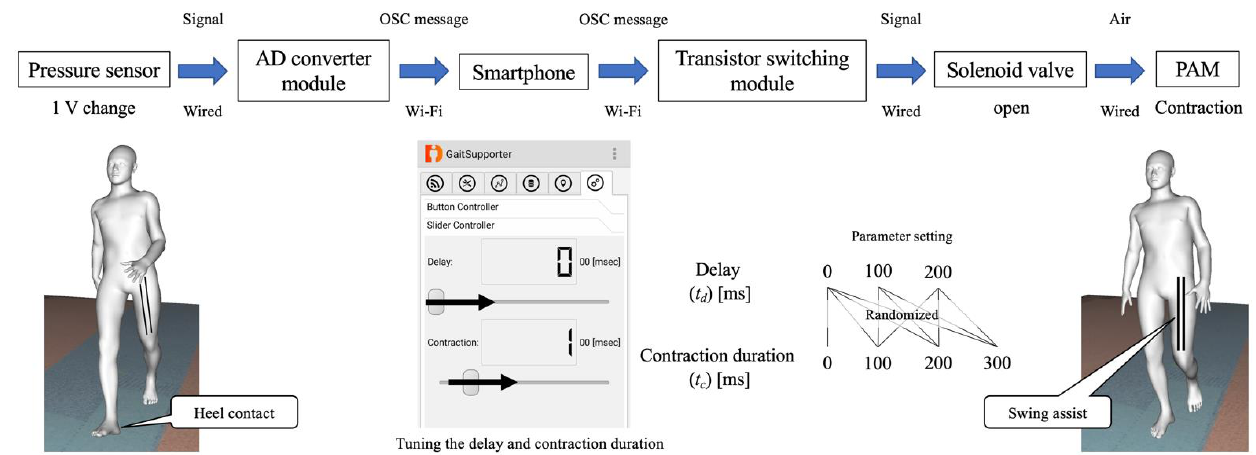
Figure 3. Control mechanism of the pneumatic artificial muscle (PAM) driver system. The signal from the pressure sensor triggers the PAM contraction. Parameter settings are randomized based on the delay from the trigger to open the solenoid valves and the contraction duration of the PAM through a slider controller with a 100 ms increment.